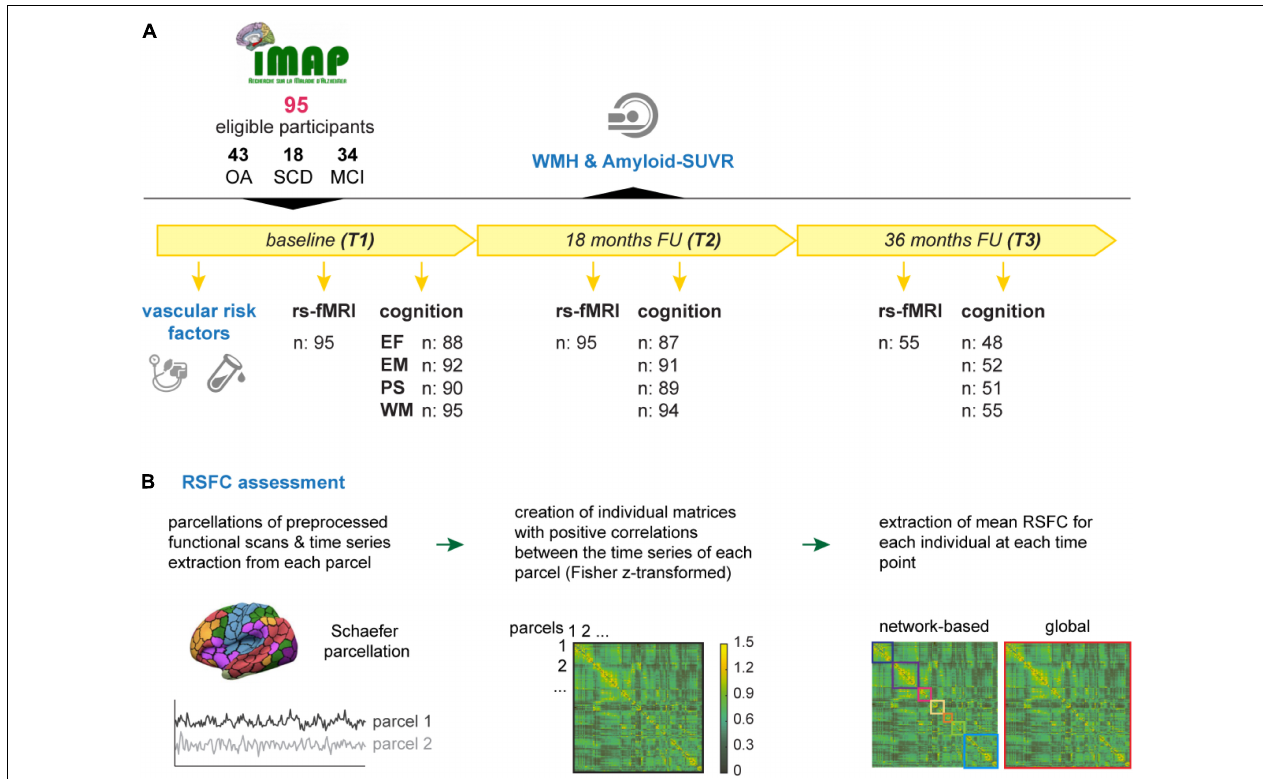
FIGURE 1 | Overview on the study design and RSFC assessment. (A) In total, 95 eligible participants of the IMAP+ cohort were followed over up to 3 years with at least two and maximal three timepoints (T1 – T3). The vascular risk factors (blood pressure, BMI, and HbA1c) were assessed at baseline. The earliest available measurement of white matter hyperintensities (WMH) and A β -PET SUVR, that were acquired along the course of the study, were considered in the current analyses. Resting-state functional magnetic resonance images (rs-fMRI) were acquired at T1 and T2 for all participant, 55 of whom also had a valid scan at T3. Cognitive performance was operationalized by composite scores of executive function (EF), episodic memory (EM), processing speed (PS), and working memory (WM) and was assessed at T1, T2, and T3. Composite scores could not be calculated for some participants due to missing data; valid numbers are shown in the figure. (B) The assessment of RSFC was carried out as follows: Individual time series of pre-processed scans were extracted from each parcel of the Schaefer parcellations atlas (Schaefer et al., 2018). Correlation matrices were obtained by correlating the time series of each parcel with one another. Correlation matrices were Fisher z-transformed and thresholded by only keeping positive correlations. Extracted mean correlations represent the indirect measure of network-based (multicolored squares) and global (red square) RSFC. BMI, body-mass-index; FU, follow up; HbA1c, glycated hemoglobin A1; MCI, mild cognitive impairment; RSFC, resting-state functional connectivity; SCD, subjective cognitive decline; Amyloid-SUVR, florbetapir standard uptake value ratio; OA, older adults.